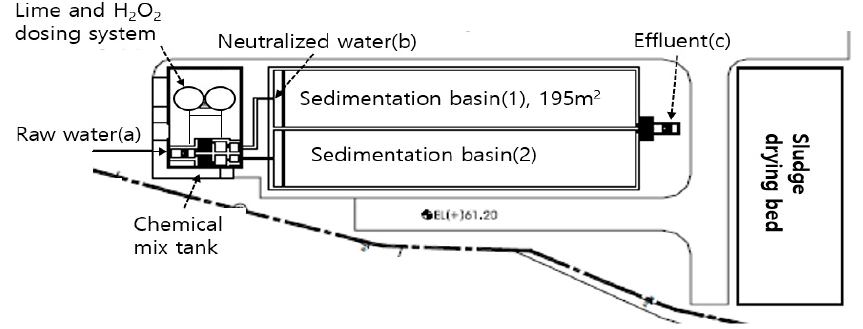
Figure 1. Sampling points (( a , b ) and ( c )) in the AMD treatment facility.